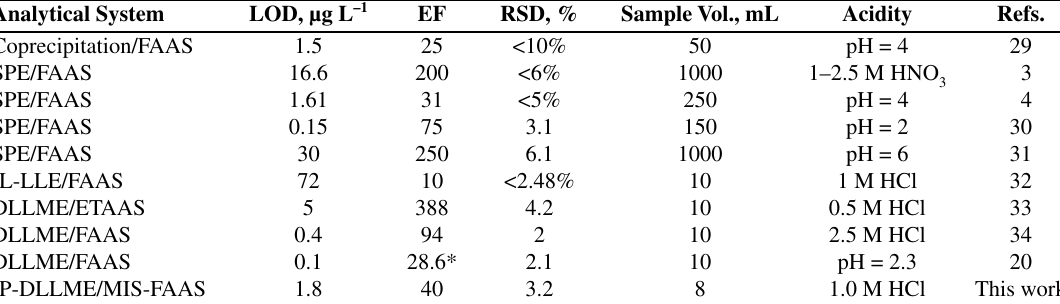
Table 8. Comparative data from some recent studies on preconcentration of gold ions Analytical System LOD, μg L –1 RSD, % Sample Vol., mL Coprecipitation/FAAS